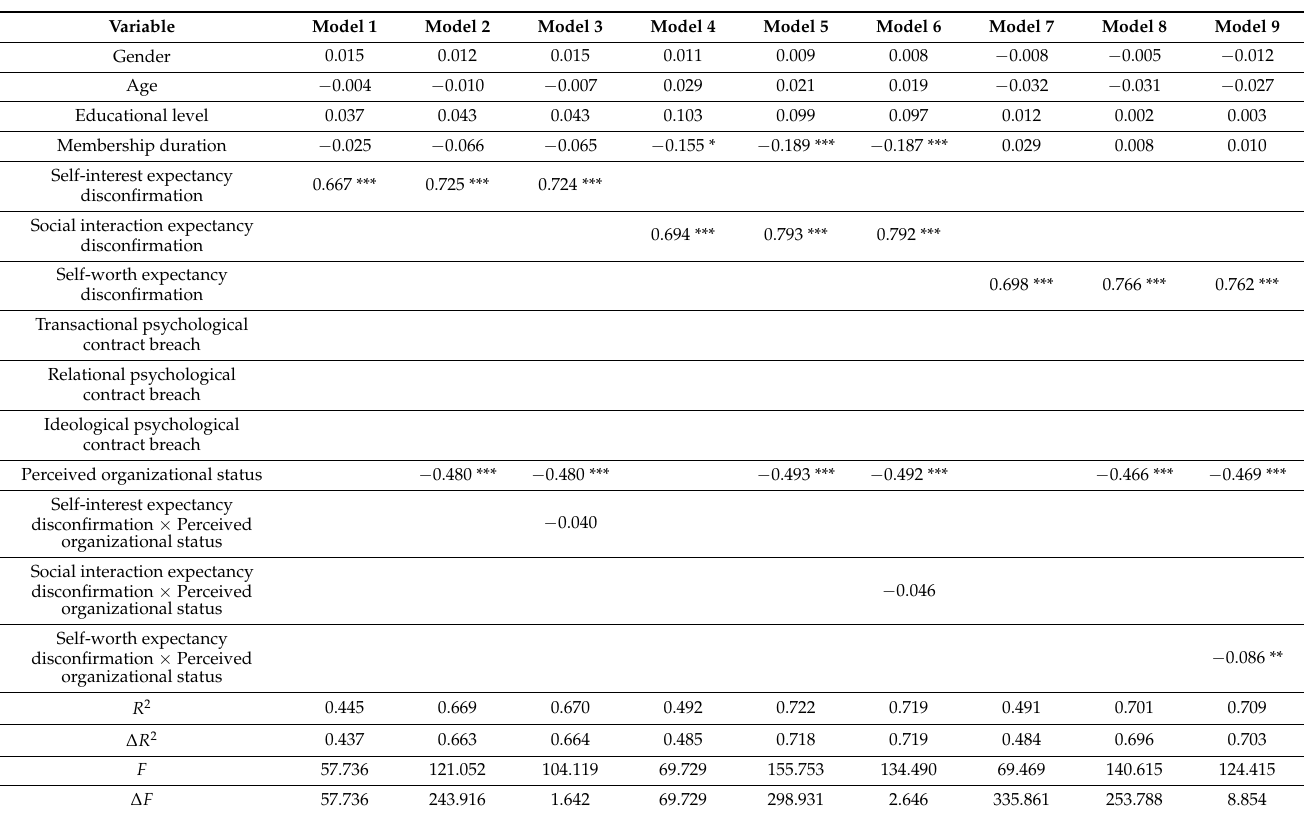
Table 9. Moderating effect of perceived organizational